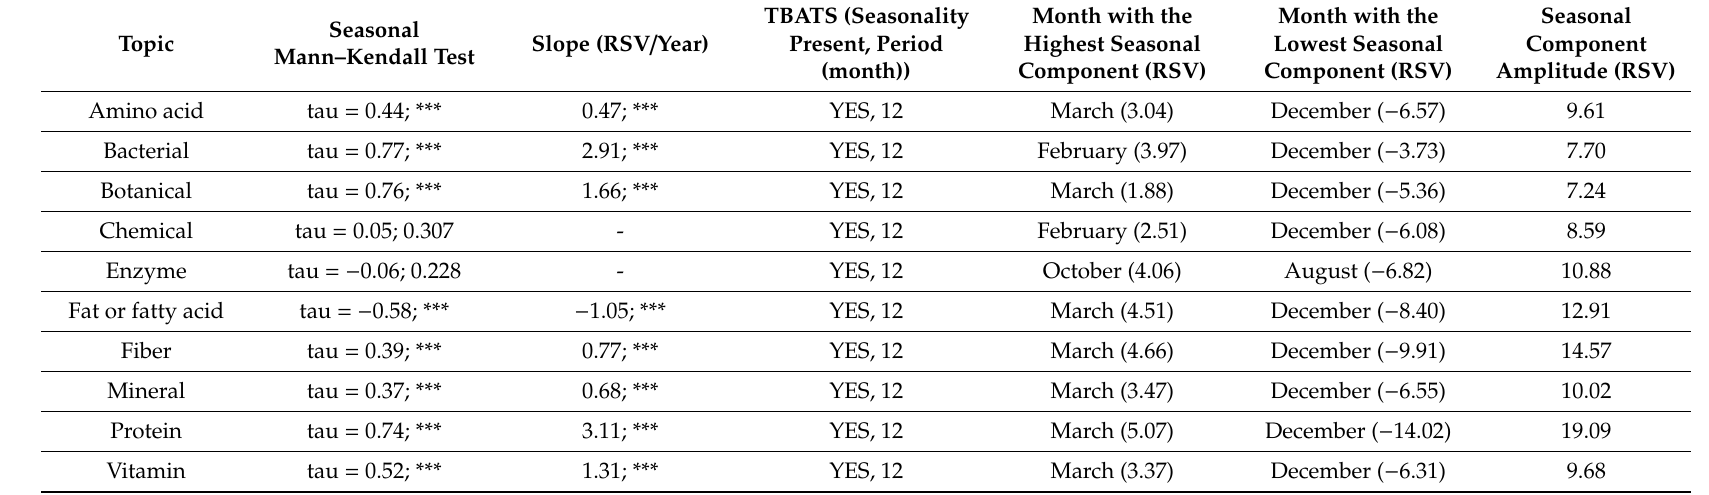
Table 3. Time series analysis of categories of topics related to dietary